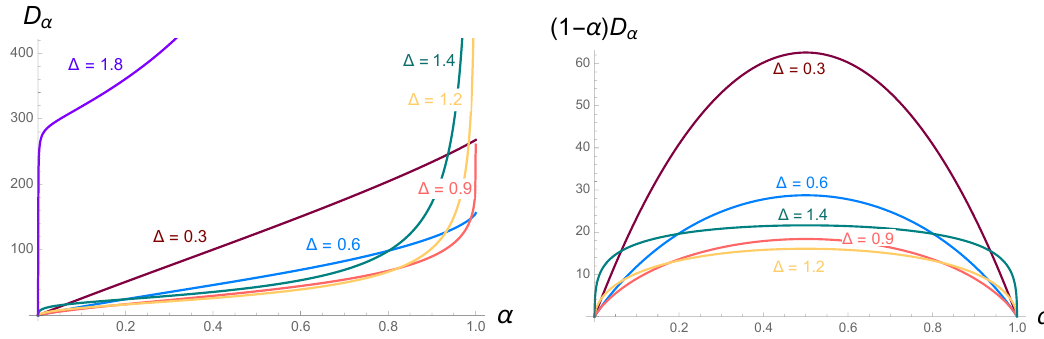
Figure 4 . D (cid:11) (left) and (1 (cid:0) (cid:11) ) D (cid:11) (right), which is concave in (cid:11) . Here (cid:21) = ~ (cid:21)= j (cid:1) (cid:0) 1 j and ~ (cid:21) (2 (cid:25)=(cid:12) ) (cid:1) (cid:0) 2 (cid:12)xed. In both plots (cid:1) = 0 : 3 ; 0 : 6 ; 0 : 9 ; 1 : 2 ; 1 : 4 and ~ (cid:15) = 0 : 001 to be able to (cid:12)t all curves in the same plot. (In the right panel we excluded the curve (cid:1) = 1 : 8, which has much bigger magnitude than the others.) The inverse temperature is (cid:12) = 2 (cid:25) and in all curves we rescaled an overall factor ~ (cid:21) 2 c L 3 (cid:25) 2 2 5